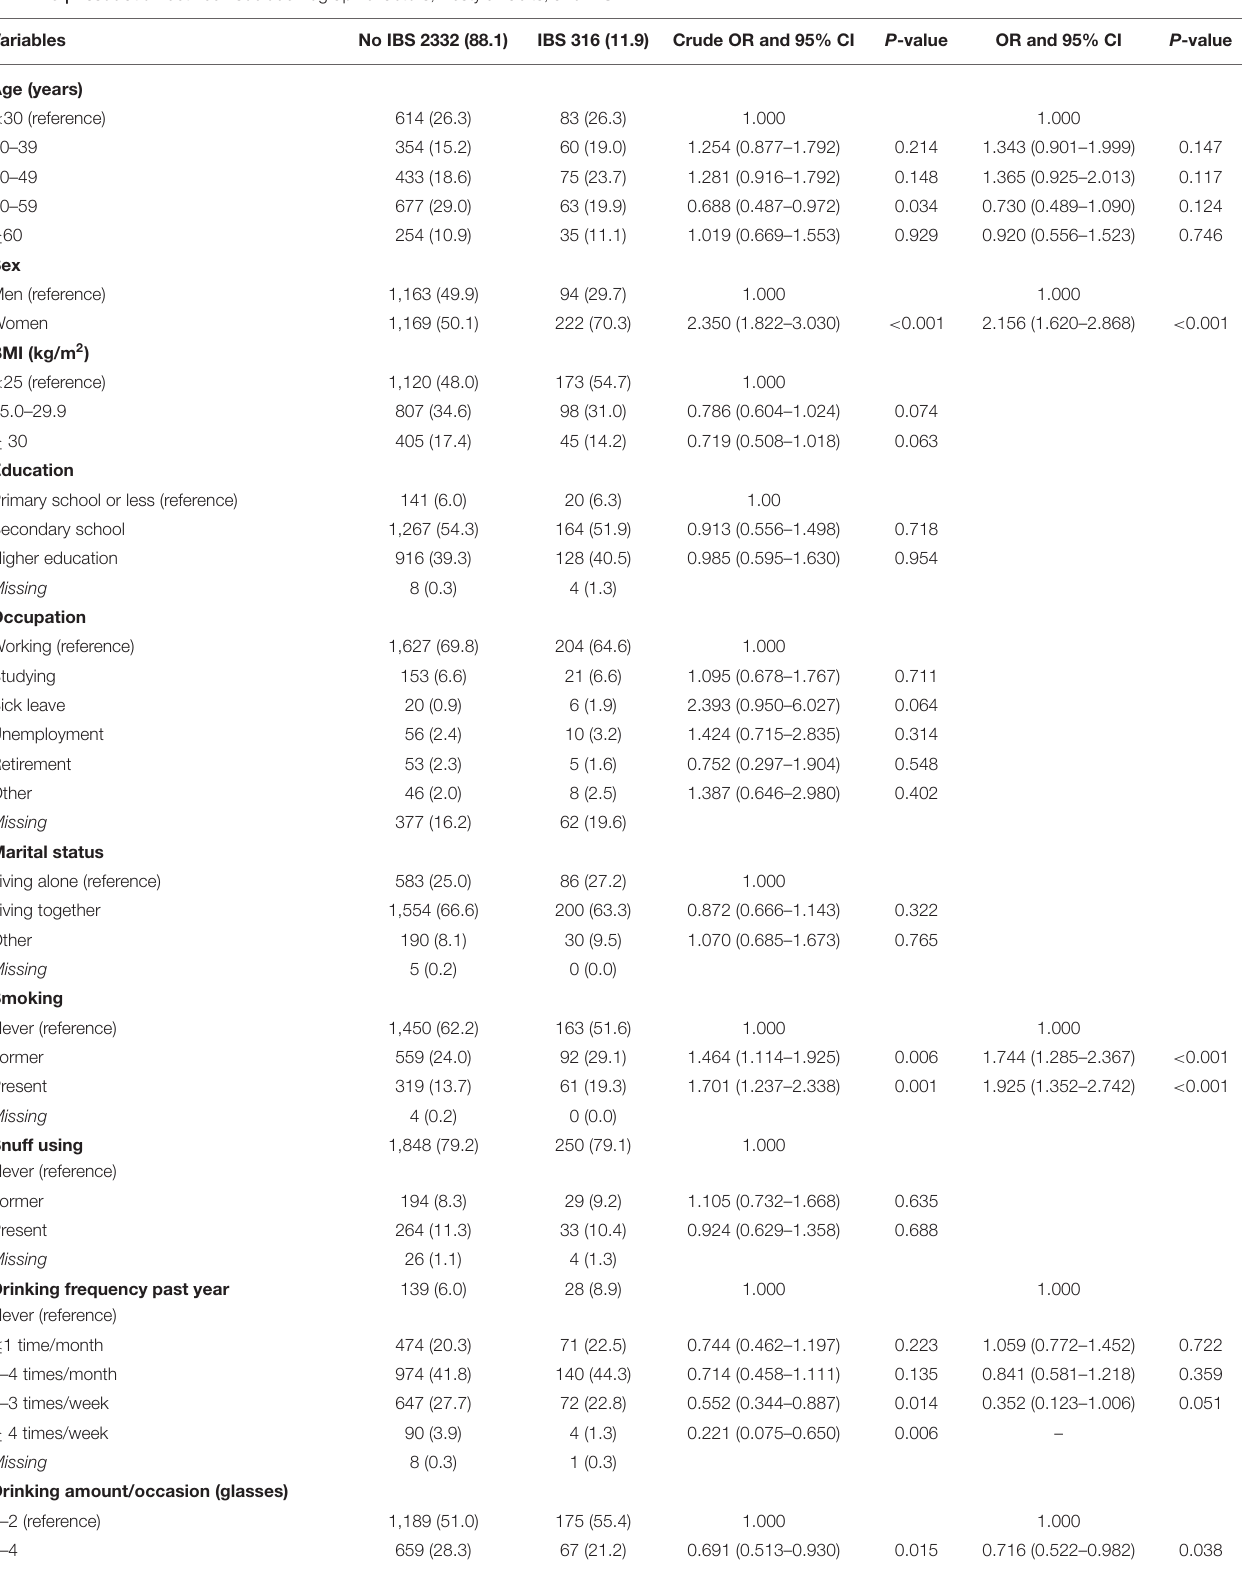
TABLE 3 | Association between sociodemographic factors, lifestyle habits, and IBS.